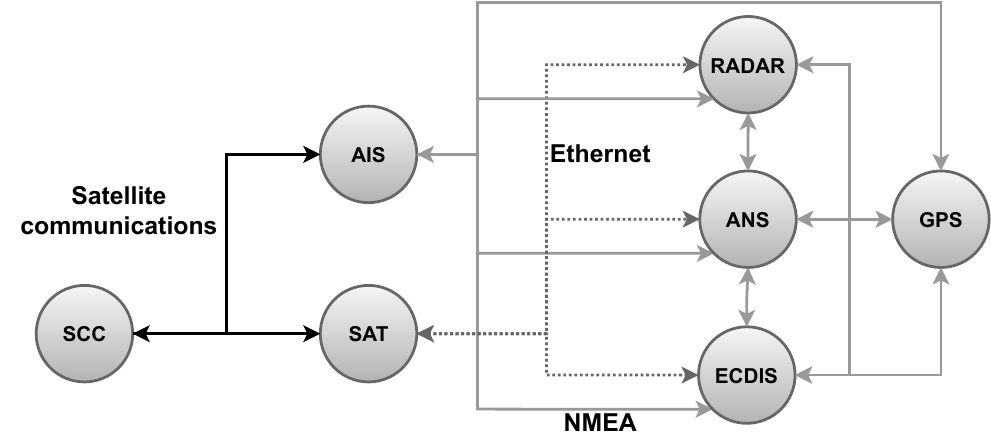
Figure 1. Architecture of the Autonomous Ship’s Navigation